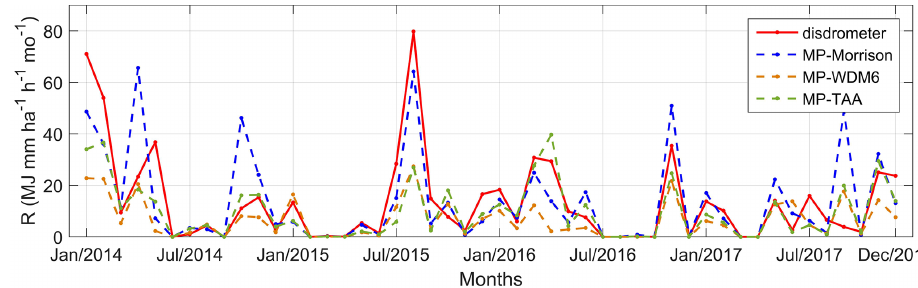
Figure 7. Comparison of disdrometer- and WRF-derived monthly rainfall erosivity estimations at Chilbolton station (2014–2017).